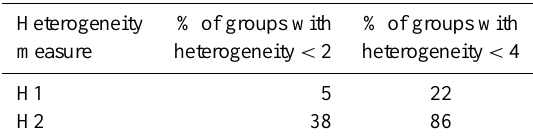
Table 5. Summary of heterogeneity measure, H1 and H2 for 85 pooling